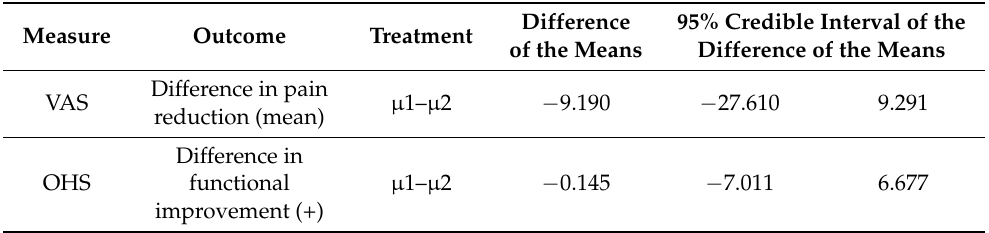
Table 6. The difference in the improvements in pain and function at 1 year after treatment of hip OA with MFAT ( µ 1 ) compared to MFAT + PRP ( µ 2